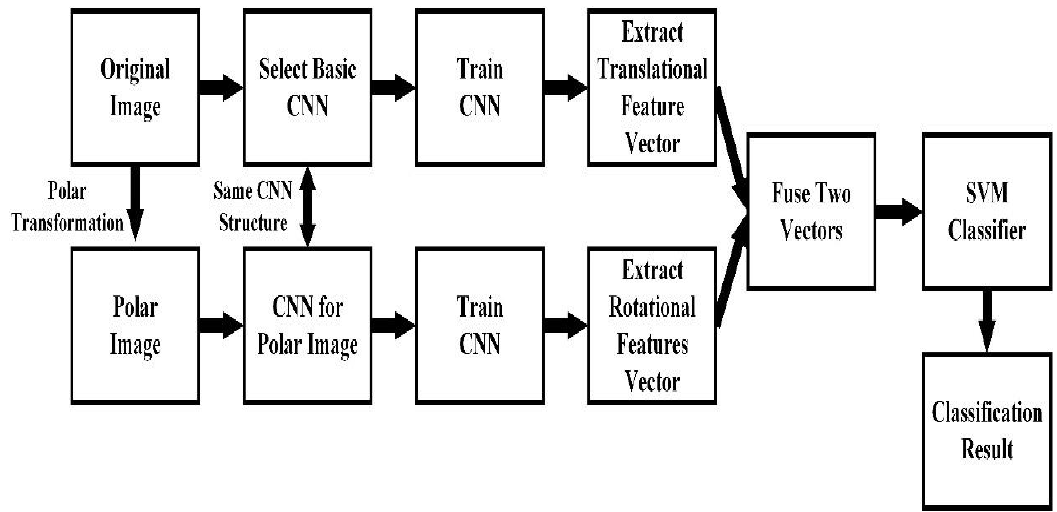
Figure 7. Block diagram of the proposed method. Note: CNN= convolutional neural network.